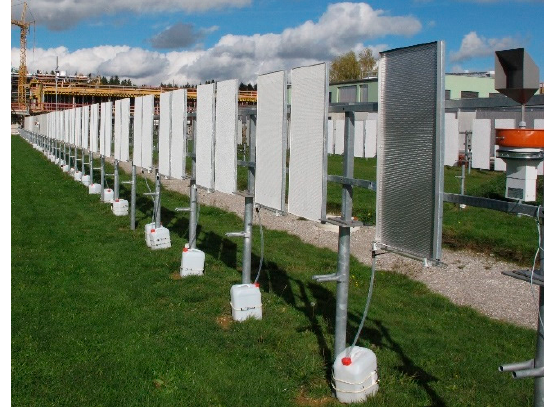
Figure 1. Vertical test panels used during leaching outdoor tests in Valley, Germany.